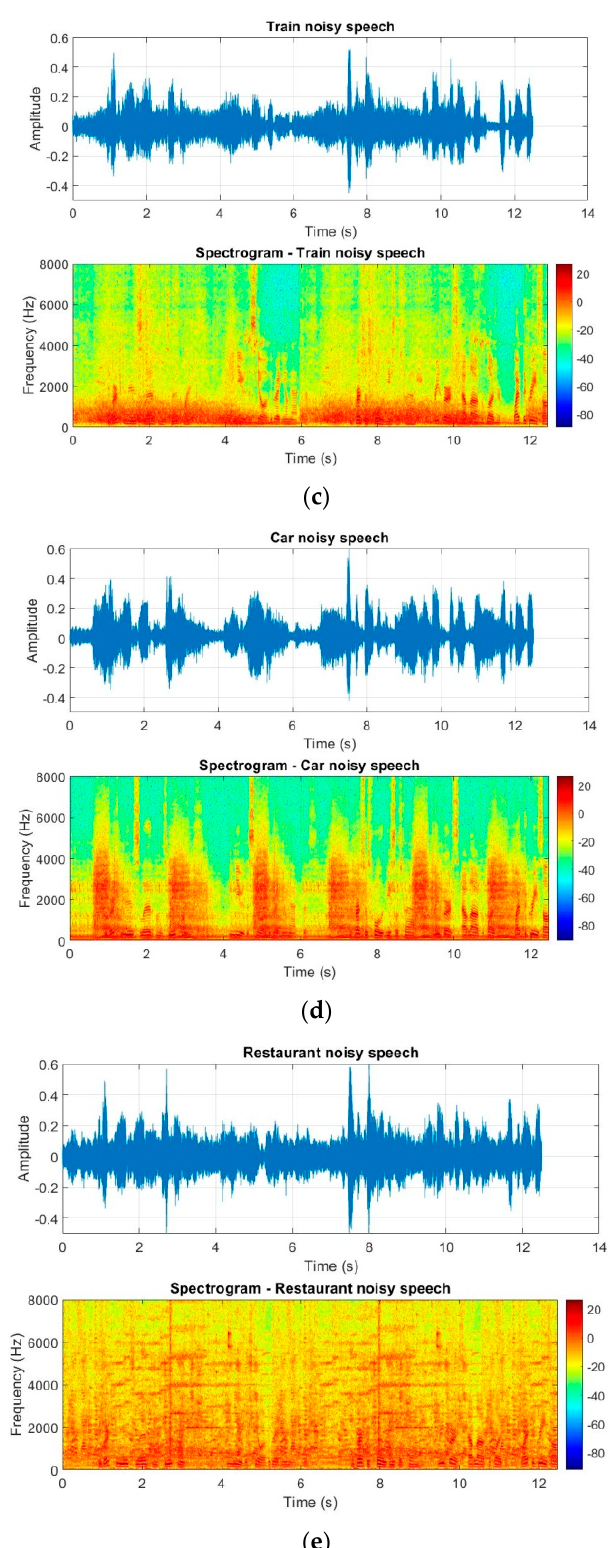
Figure 10. The time-domain and spectrum for a noisy speech signal with ( a ) white noise, ( b ) babble noise, ( c ) train noise, ( d ) car noise, and ( e ) restaurant noise according to a signal-to-noise ratio (SNR) = 0 dB.